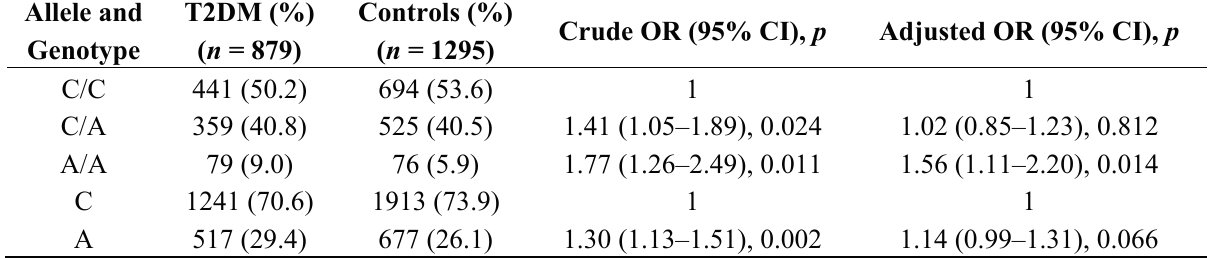
Table 3. Genotype and allelic distributions of the rs6721961 polymorphism of the NRF2 gene in participants.